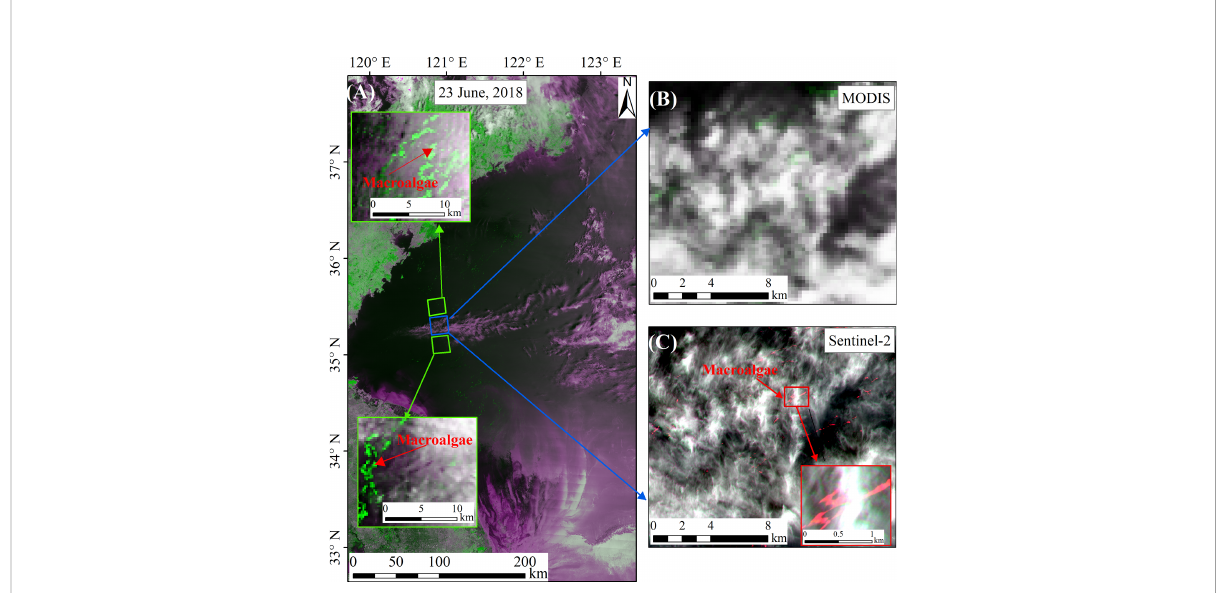
FIGURE 1 (A) Macroalgae shown in a false color composite by MODIS bands 1, 2, 1 acquired over the Yellow Sea on 23 June 2018. The green patches indicated by red arrows in green frame are fl oating green macroalgae, and the white patches in blue frame are clouds. (B) Details of blue frame shown in MODIS false color image. (C) Details of blue frame shown in Sentinel-2 false color image composite by bands 8, 4, 3 acquired on the same day as MODIS. In the false color images, the fl oating macroalgae patches are in red